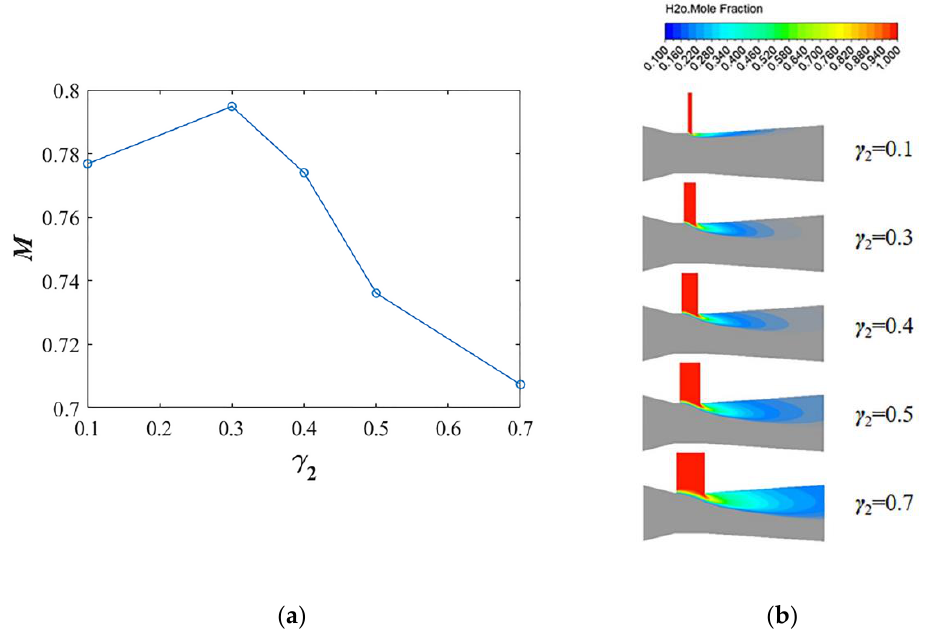
Figure 11. The effects of pore-throat diameter ratio on the ( a ) M ( b ) concentration distribution of the jetting flow in the VTM.